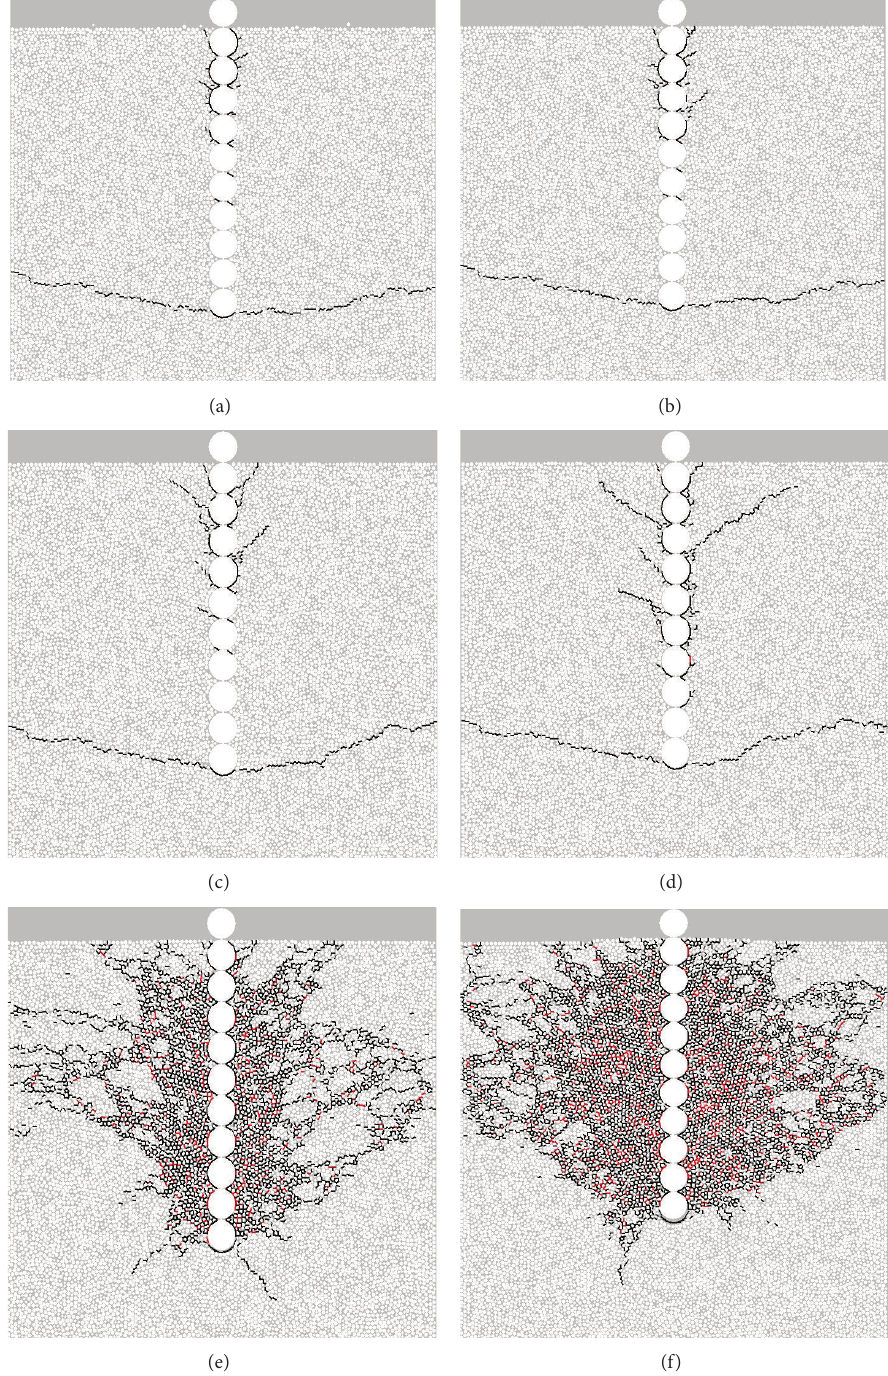
Figure 12: Failure patterns under different loading rates. (a) 5 mm/s; (b) 10 mm/s; (c) 50 mm/s; (d) 100mm/s; (e) 500 mm/s; (f)